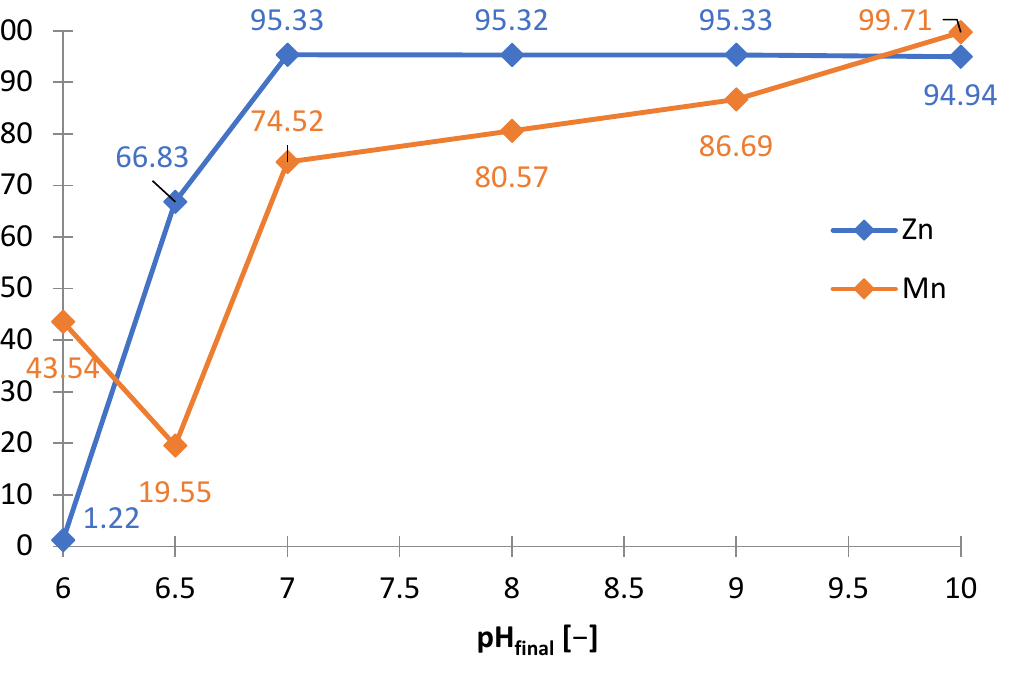
Figure 29. Effect of final pH (pH final ) on precipitation yields ( µ X ) of zinc and manganese during precipitation by using Na 2 CO 3 from solution after selective leaching. Table 8. Conditions of pH and amount of Na 2 CO 3 during precipitation of zinc and manganese from solution after selective